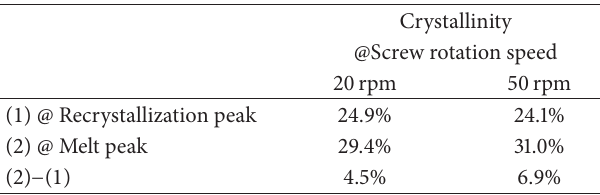
Table 3: Crystallinity of as-spun PET bristles extruded at different screw rotation speeds at a take-up speed of 10m ⋅ min −1 .